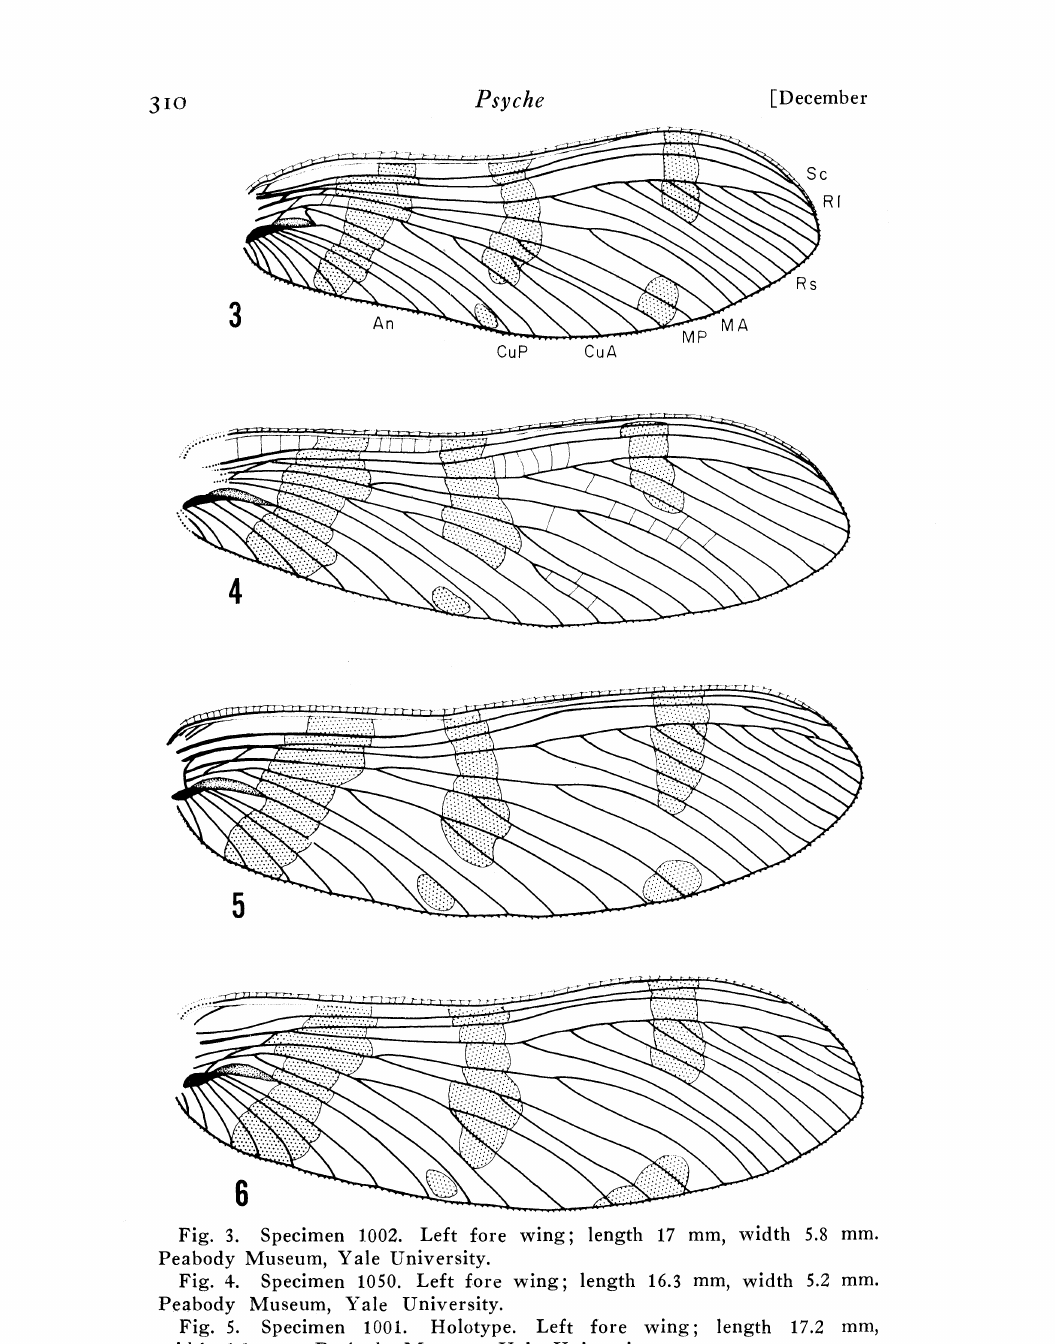
Fig. 3. Specimen 1002. Left fore wing; length 17 mm, width 5.8 mm. Peabody Museum, Yale University. Fig. 4. Specimen 1050. Left fore wing; length 16.3 mm, width 5.2 mm. Peabody Museum, Yale University. Fig. 5. Specimen 100i. Holotype. Left fore wing; length 17.2 mm, width 5.5 mm. Peabody Museum, Yale University. Fig. 6. Specimen 1001. Right fore wing; length 17.2 ram, width 5.5 ram. Peabody Museum, Yale